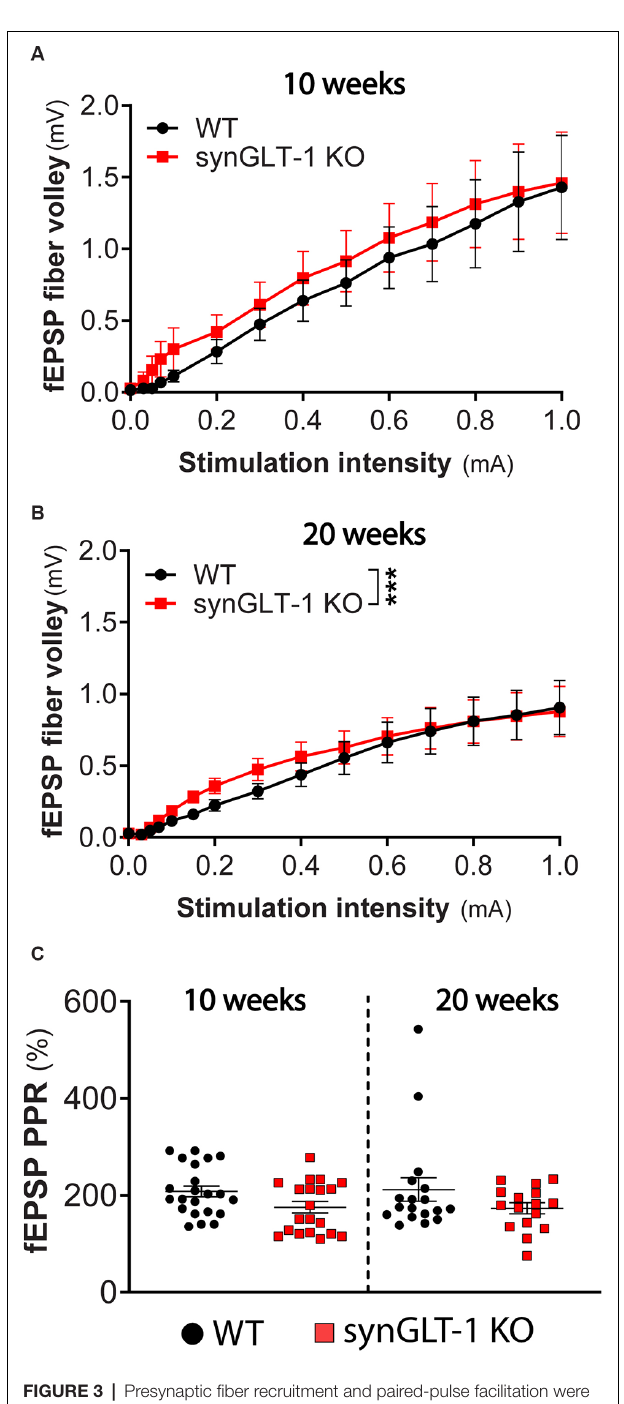
FIGURE 3 | Presynaptic fiber recruitment and paired-pulse facilitation were largely unchanged in synGLT-1 KO compared to wild-type littermates. The fEPSP fiber volley component of field potential recording in the stratum pyramidale of CA1 hippocampal slices in 10 (A) and 20 weeks old (B) synGLT-1 KO (red traces) and WT littermate controls (black traces) is shown. (C) Pair pulse facilitation ratio (PPR) of two paired electrical stimuli at 20 Hz applied to the Schaeffer collateral/commissural fibers in 10 weeks (left) and 20 weeks (right) old WT littermate controls (black symbols) and synGLT-1 KO (red symbols). *** = p < 0.001 in panel (B) indicates the effect of genotype in a linear mixed